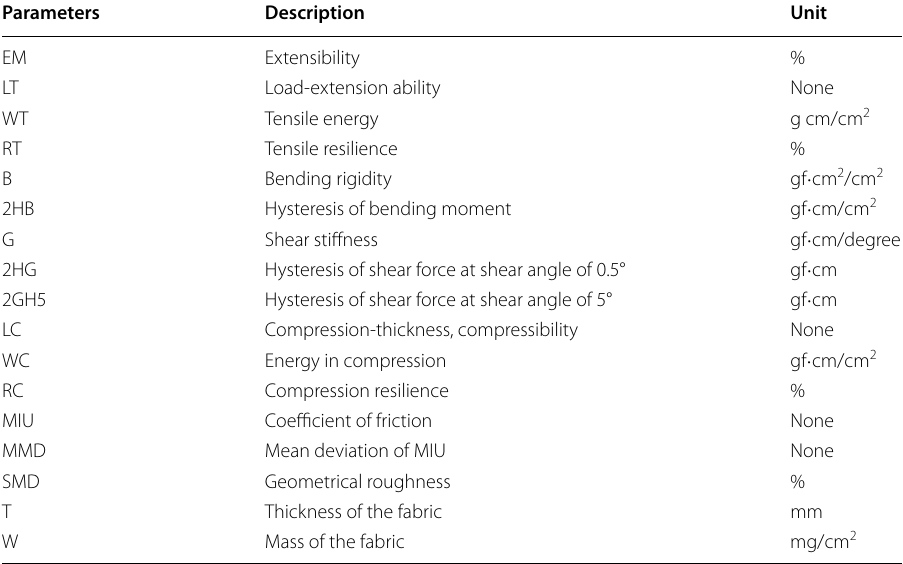
Table 1 Characteristic values of basic 16 mechanical properties of fabrics Parameters